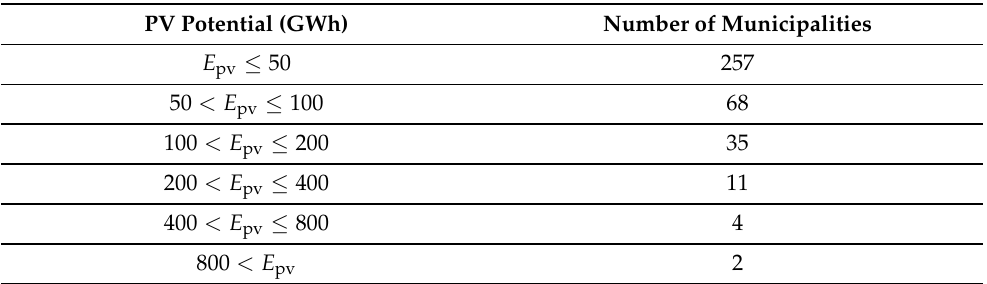
Table 1. Summary table of annual photovoltaic potential by number of